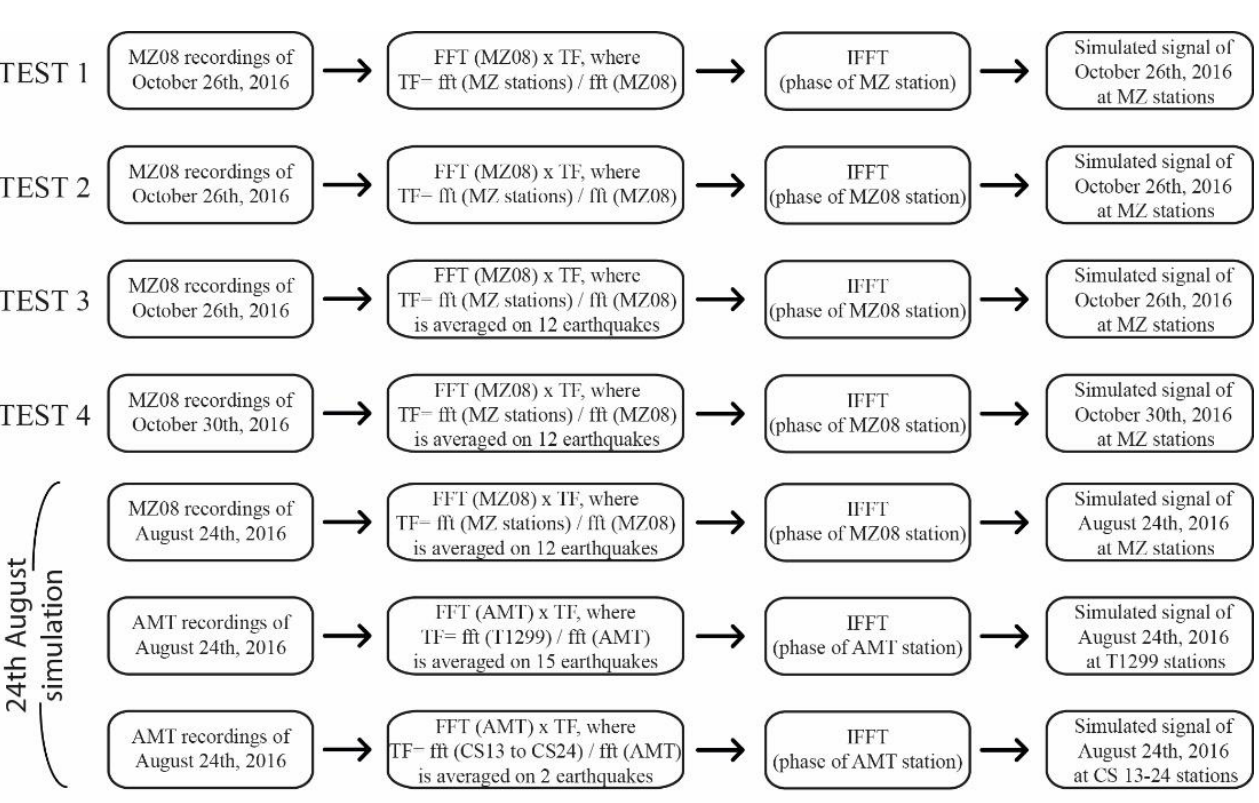
Figure 5. Flowchart of the simulation procedure for the four tests and the final simulation of 24 August 2016 earthquake. FFT, fast Fourier transform; IFFT, inverse fast Fourier transform; TF, transfer function (SSR).